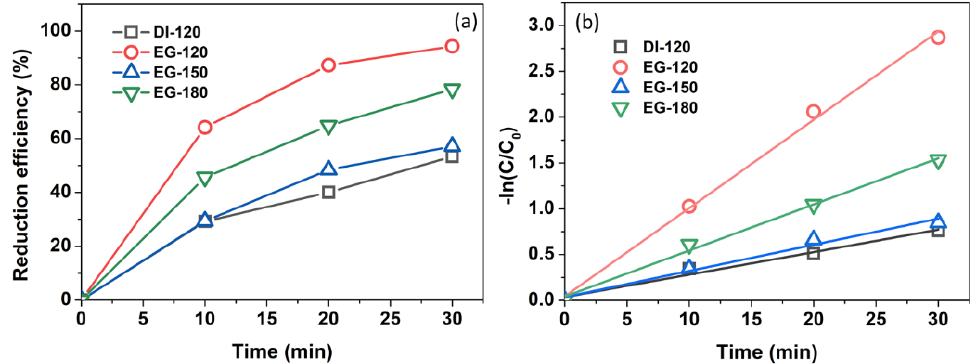
Figure 3. ( a ) Photoreduction efficiency of Cr(VI) and ( b ) kinetic models by different ZnIn 2 S 4 photo- catalysts under visible light irradiation.